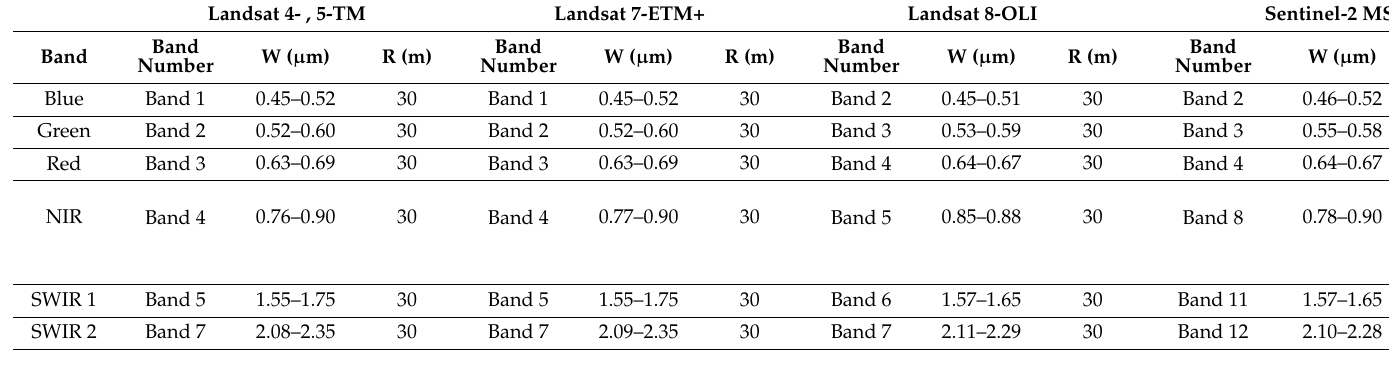
Table 1. Main spectral and spatial resolution characteristics of the selected satellites: Landsat 4- and 5-Thematic Mapper (TM), 7-Enhanced Thematic Mapper Plus (ETM+), 8-Operational Land Imager (OLI), Sentinel-2 multispectral instrument (MSI), and Terra–Aqua Moderate Resolution Imaging Spectroradiometer (MODIS). Note that only bands commonly used in water detection methods are reported. (W and R stand for wavelength and spatial resolution, respectively). Landsat 4- ,